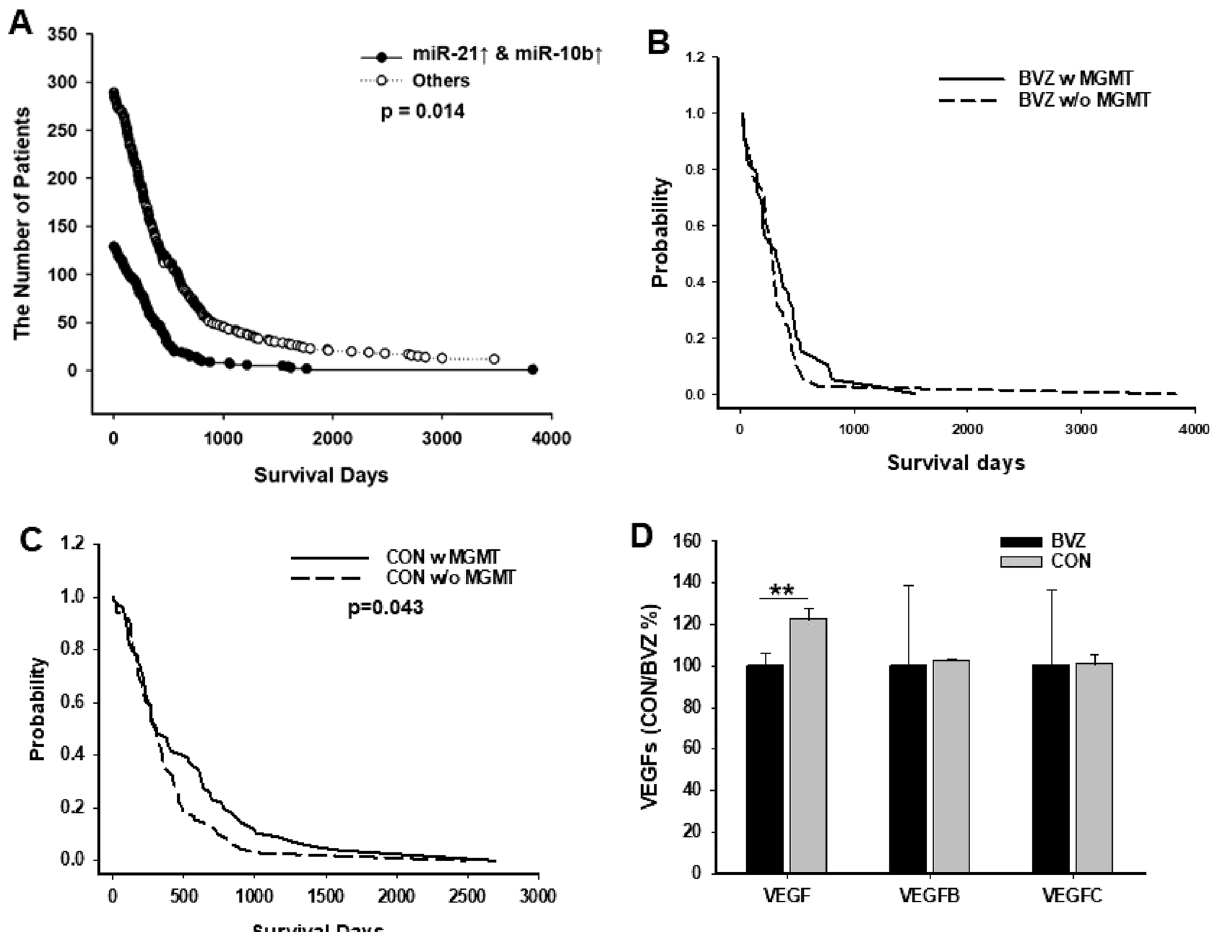
Figure 3. Distinct clinical characteristics of GBM BVZ subtypes. ( A ) Kaplan–Meier survival curves for the GBM BVZ subtype and the control ( p = 0.014, Wilcoxon-Mann). ( B ) Kaplan–Meier survival curves for GBM BVZ patients in each subclass (w or w/o MGMT methylation) of the entire subtype are shown ( p > 0.05). ( C ) Kaplan–Meier survival curves for GBM CON patients in each subclass are shown ( p = 0.043, Wilcoxon-Mann). Black or dashed lines represent the survival of patients with or without MGMT methylation, respectively. ( D ) Comparisons of the gene methylation of VEGF, VEGFB, and VEGFC between GBM BVZ subtypes are shown. There was only one significant difference between GBM BVZ and CON subtypes in VEGF methylation ( p = 0.005,